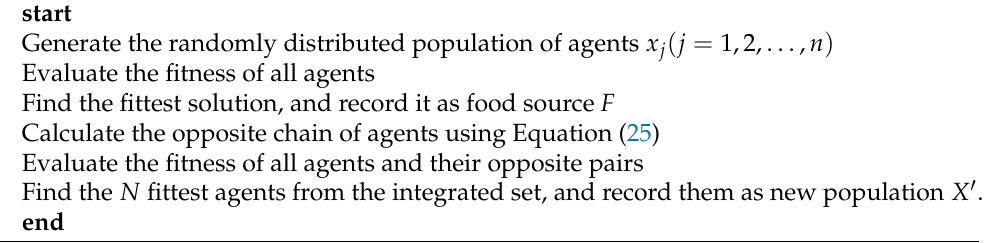
Algorithm 3 Pseudo-code of the OBL-based process.